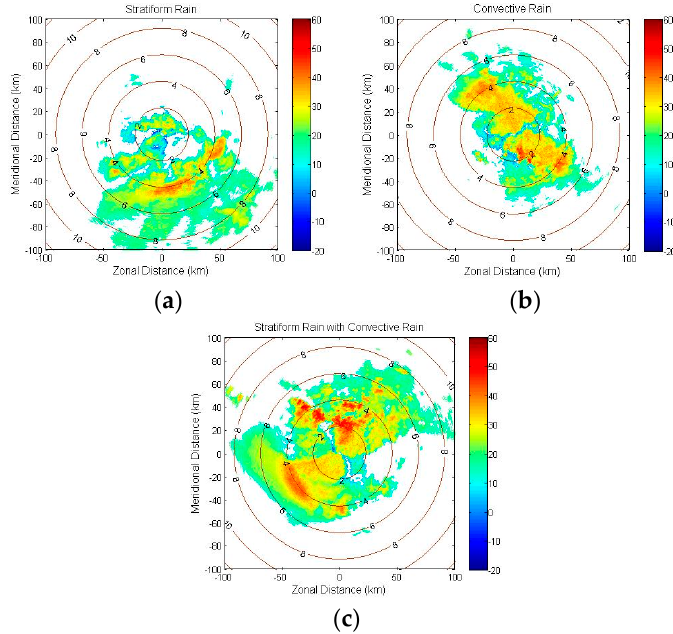
Figure 3. Dual-polarized radar PPI images of Z for ( a ) stratiform rain only, ( b ) convective rain only, and ( c ) stratiform rain together with convective rain.